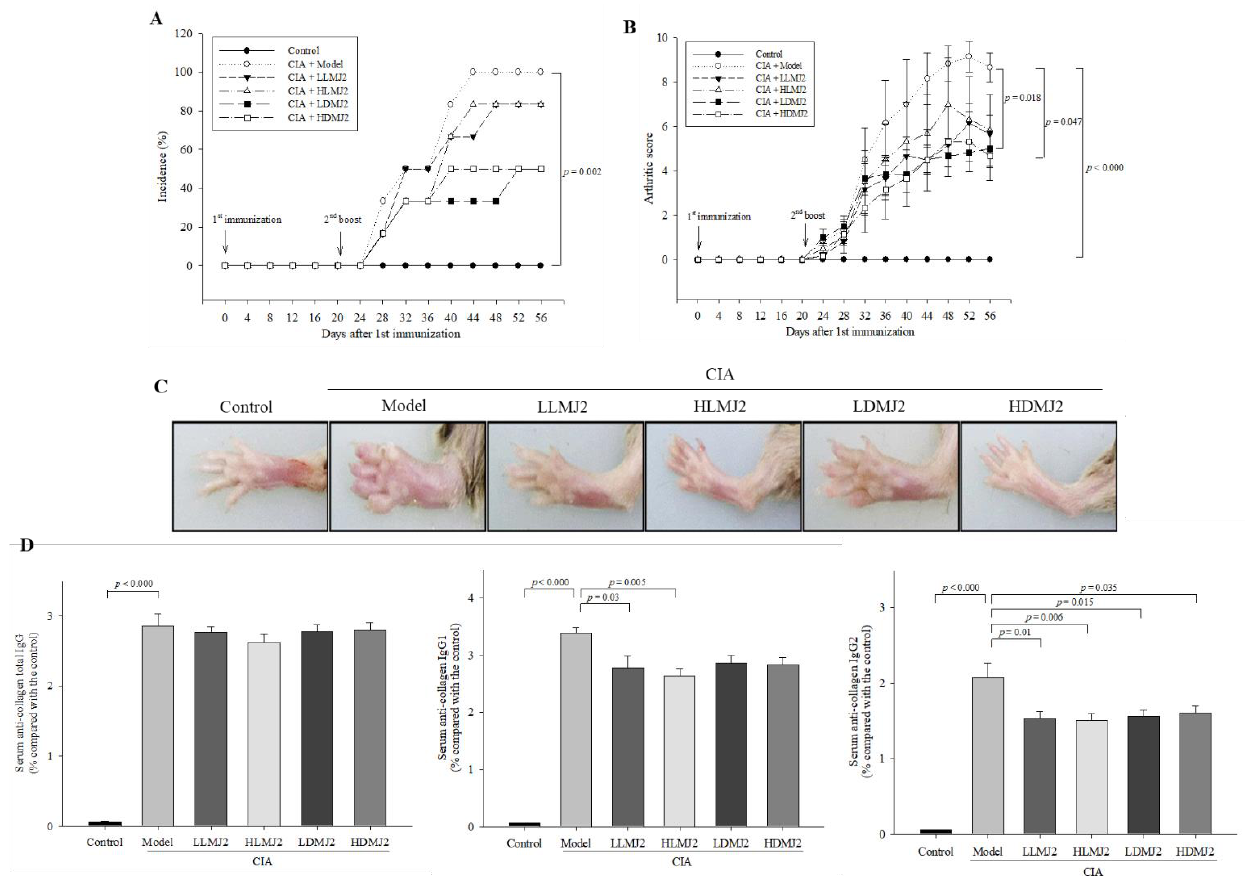
Figure 4. Effects of MJ2 on collagen-induced arthritis (CIA)-associated symptoms ( n = 8 per group). Incidence of arthritis ( A ), rheumatic clinical score ( B ), and representative images of mice paw thickness ( C ). Levels of collagen-specific IgG antibodies were measured by ELISA ( D ). Data values indicate the mean ± standard error of the mean (SEM). One way ANOVA followed by Tukey’s HSD was used to determine significance.